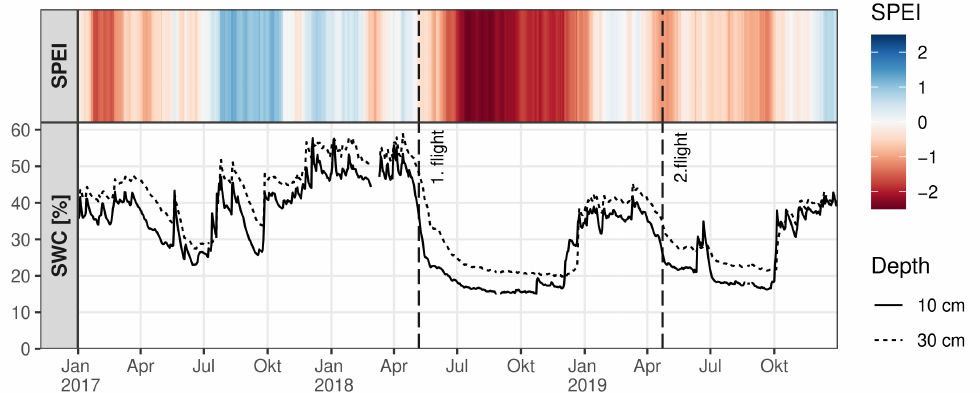
Figure 3. Time series of 91-days/3-months standardised precipitation-evapotranspiration index (SPEI) and relative soil water content (SWC) values for the research site DE-GsB. Vertical dashed lines indicate the dates of hyperspectral imaging flights.